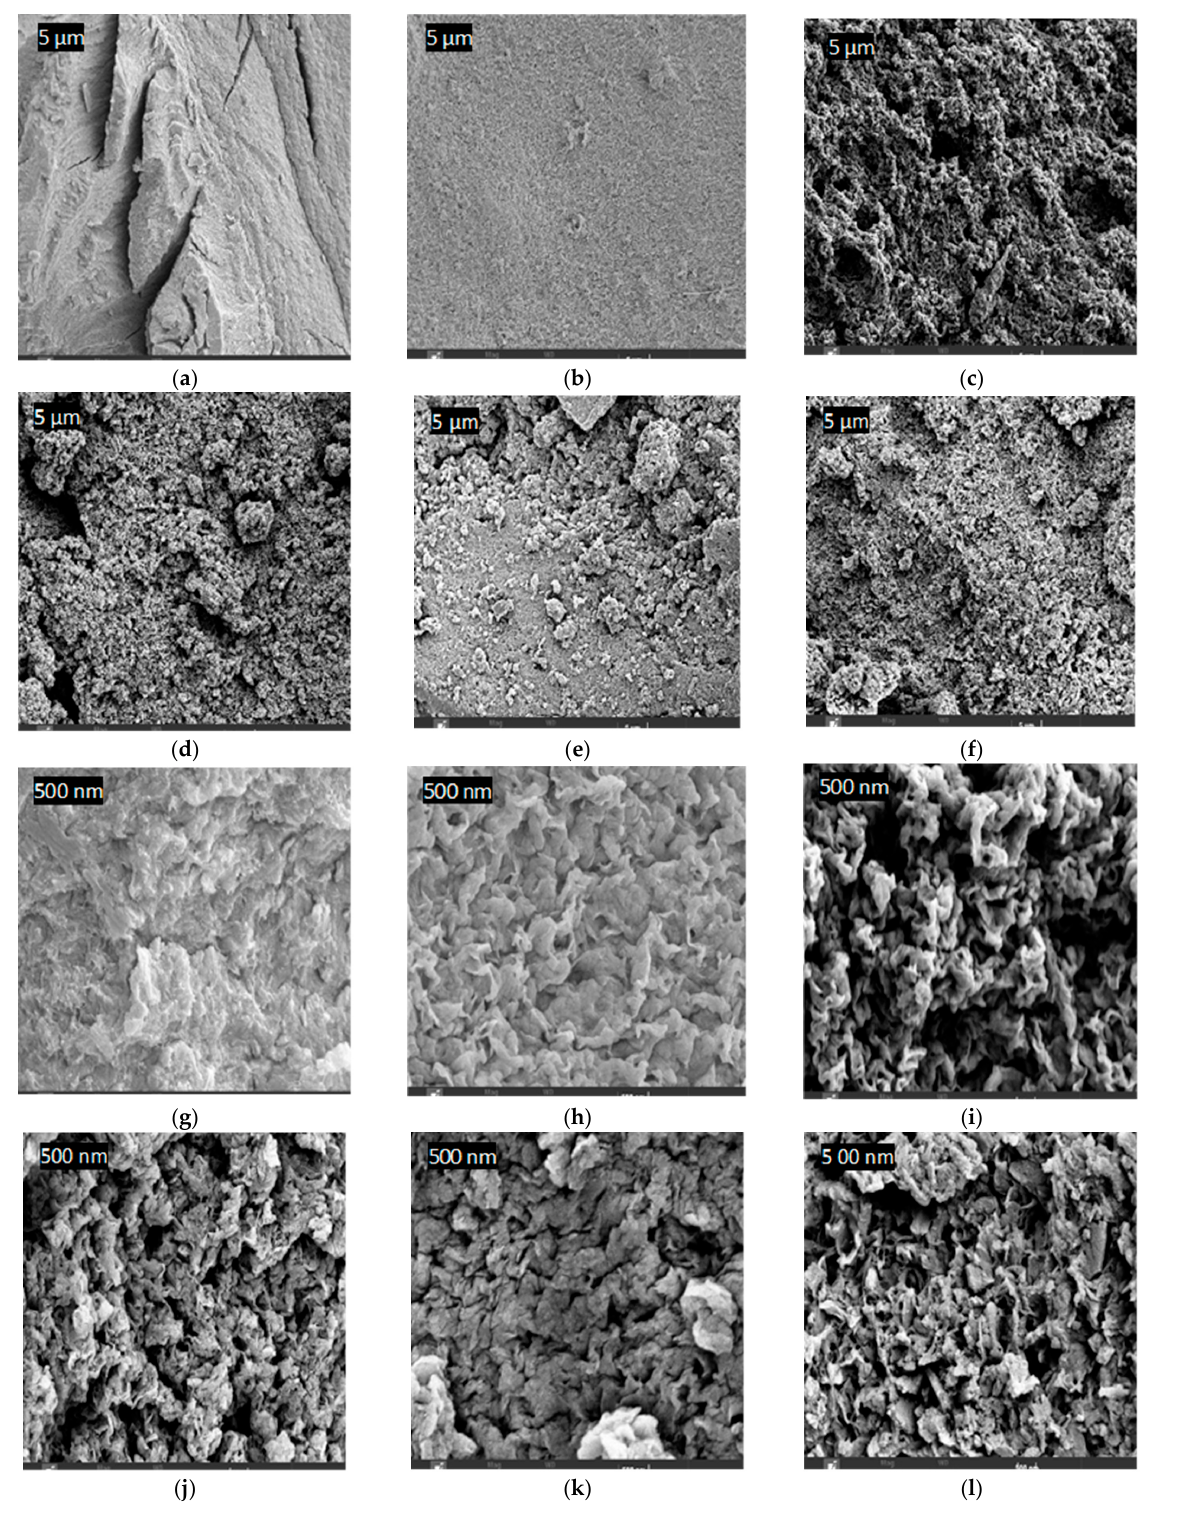
Figure 14. FESEM images of the samples: ( a ) PPS at 5 µm, ( b ) PPS-2 at 5 µm, ( c ) PPS-4